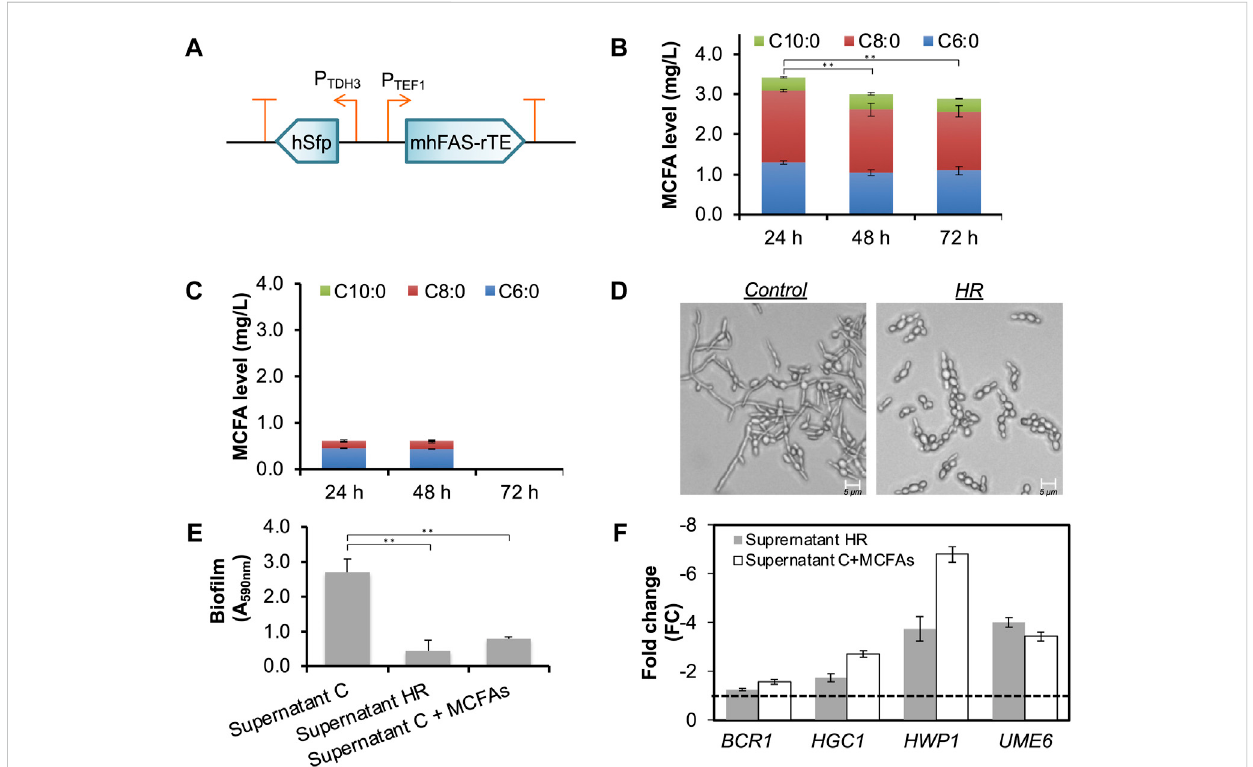
Chromosomal constitutive expression of an MCFA biosynthetic pathway and the functional analysis of the secreted MCFAs. (A) . Schematic of the recombinant plasmid pESC-HR harboring the MCFA biosynthetic pathway under the control of constitutive promoters (P TEF1 and P TDH3 ). (B) . The time- courseproductionlevelofMCFAssecretedintothemedium.Thedatawasobtainedfromatleastthreeindependentexperiments. (C) .MCFAssecretedby CLPY02 inYGD medium. (D) . Effect of theMCFA-containing supernatantfrom CLPY04 (HR) on hyphal formation atpH5.5.Control, thesupernatant of CLPY01 which does not contain MCFAs. (E) . Effect of Supernatant HR on bio fi lm formations in the customized DMEM. Supernatant C, the supernatant of CLPY01. Supernatant C + MCFAs, Supernatant C with MCFA spike-in. (F) . Real-time PCR (RT-PCR) analysis of the gene pro fi le in SC5314 co-cultured with Supernatant HR. Expression of genes related to bio fi lm and hyphal formation was analyzed. Supernatant C was used as a control. Reference gene, ACT1 . A dotted line indicates FC1.0, representing the fold change (FC) of genes from the control. The pH of Supernatant C and Supernatant HR